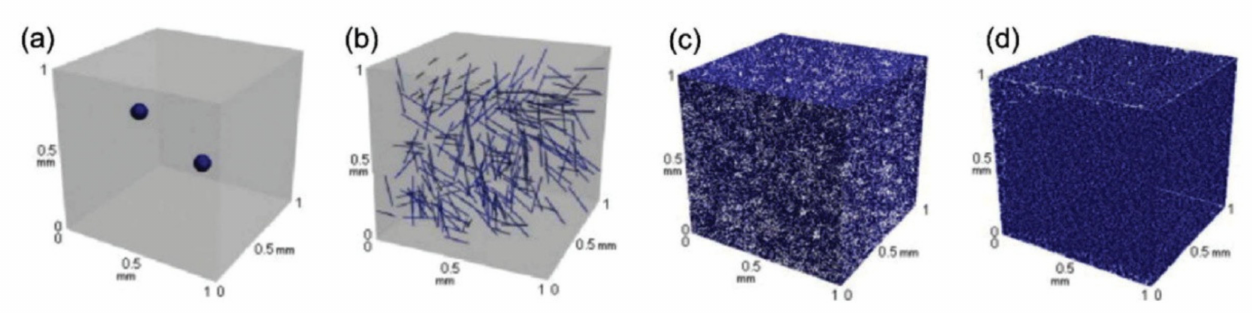
Figure 2. Micro and nano scale distribution of; ( a ) Al 2 O 3 particles, ( b ) carbon fibers, ( c ) graphene nanoplatelets (GNPs), and ( d ) CNTs. Reproduced with permission from [38]. Copyright Elsevier,